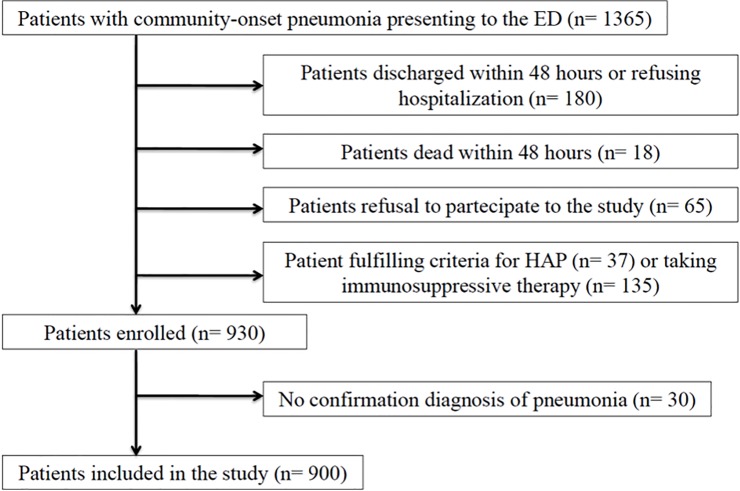
Study flow diagram.Legend. ED: emergency department; HAP: hospital-acquired pneumonia.